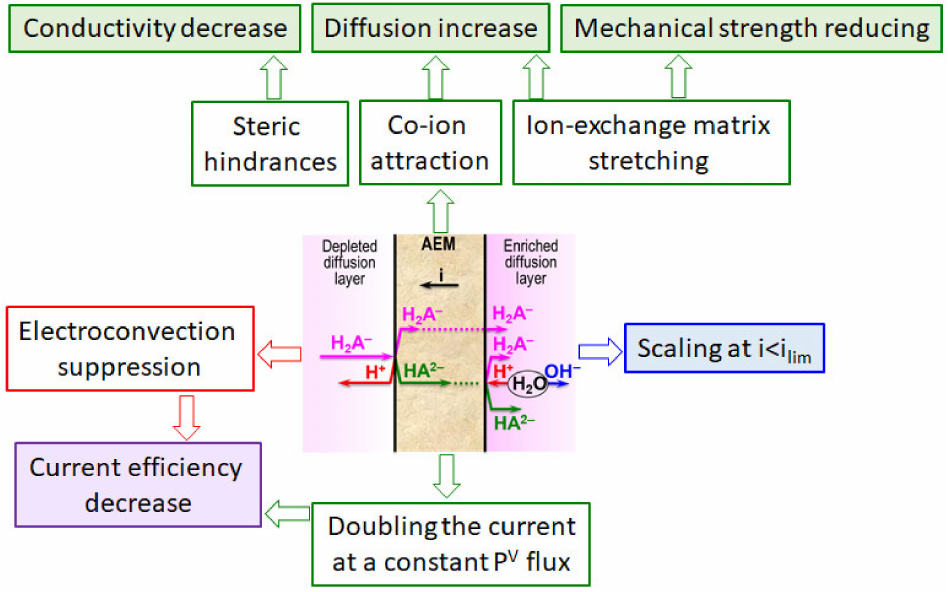
Figure 21. Factors determining the mass transfer characteristics of AEM in solutions containing phosphoric acid